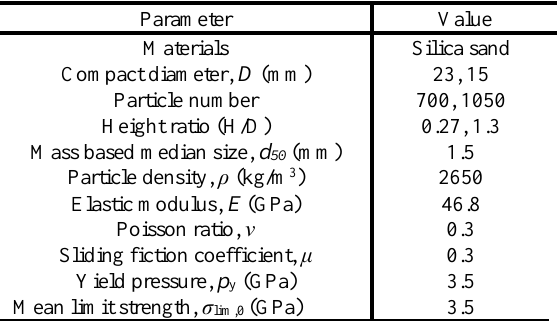
Table. 1 Parameters used in the simulations Parameter Value Materials Silica